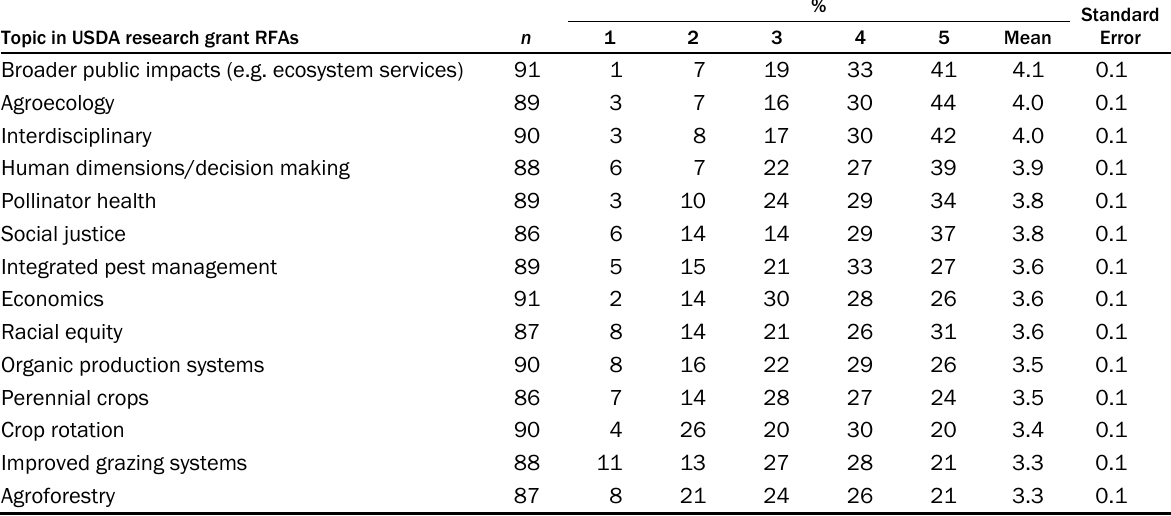
Table 2. Importance for Requests for Applications to Reference Range of Topics in Sustainable